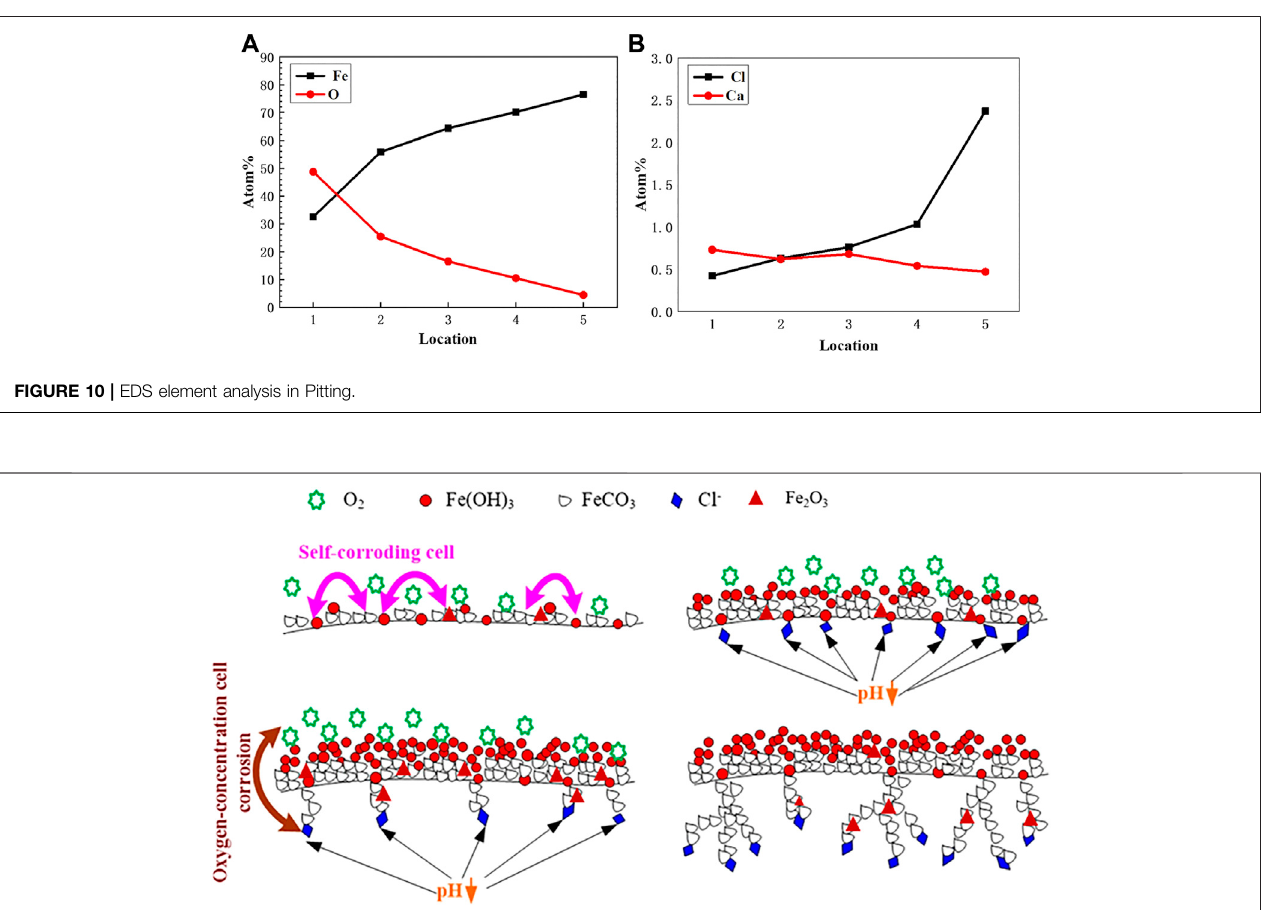
Frontiers in Materials |